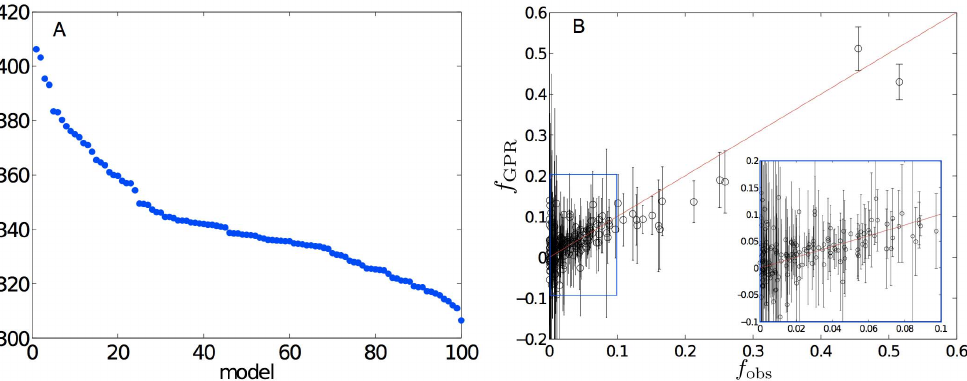
Figure 2. A: Marginal log likelihood for 100 models that each are distinct local maxima of Eq. (8). The model with the highest value is used for the rest of the analysis. B: Scatter plot of the observed output function f obs ~ validation with 95% confidence intervals. The inset details the low propensity data. doi:10.1371/journal.pone.0101123.g002 PLOS ONE |